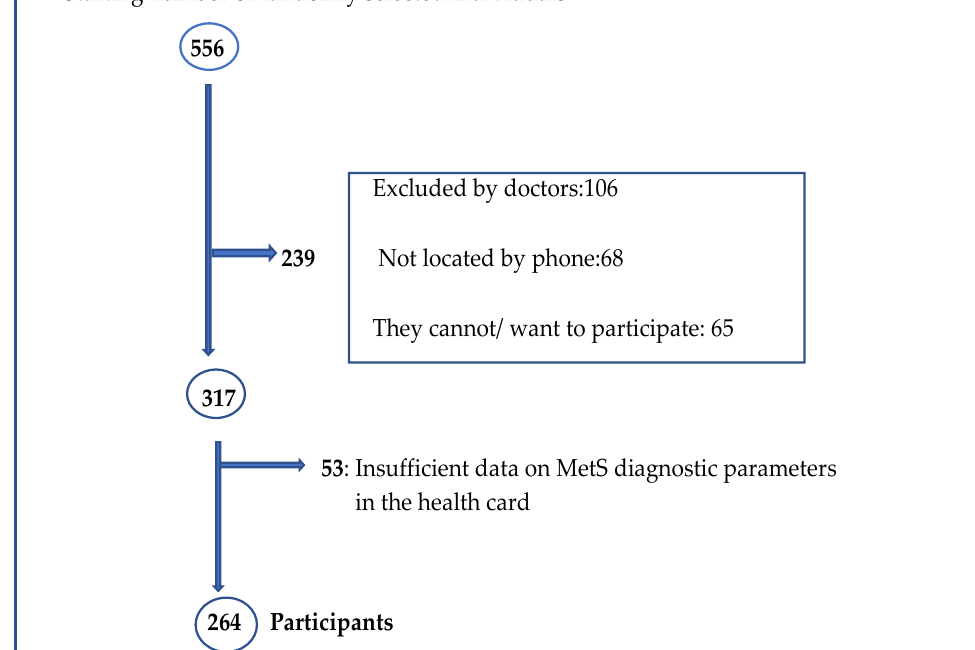
Figure 1. Flow chart of the participant selection process.